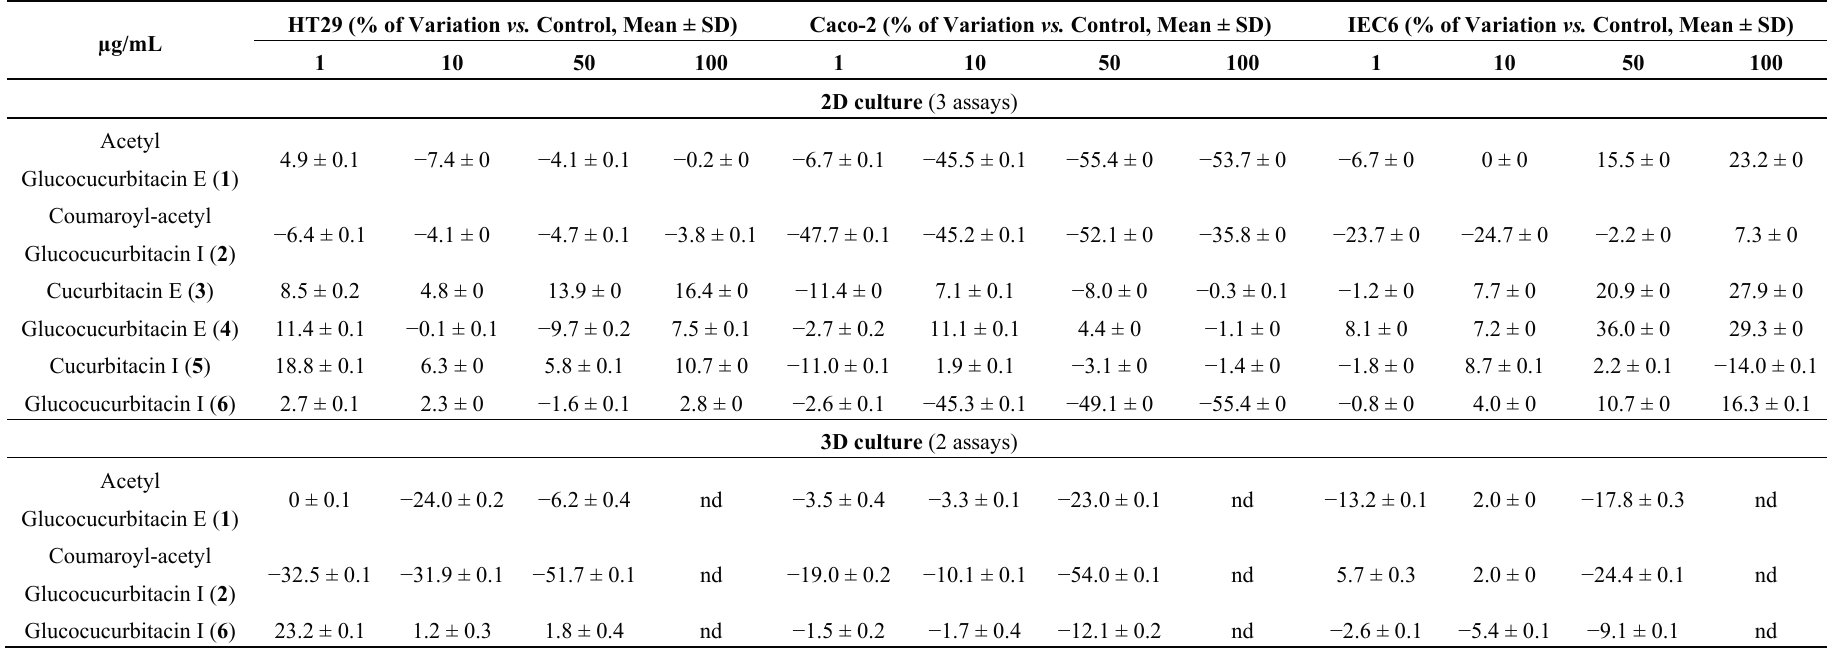
Table 2. Cytotoxic activities of compounds 1 – 6